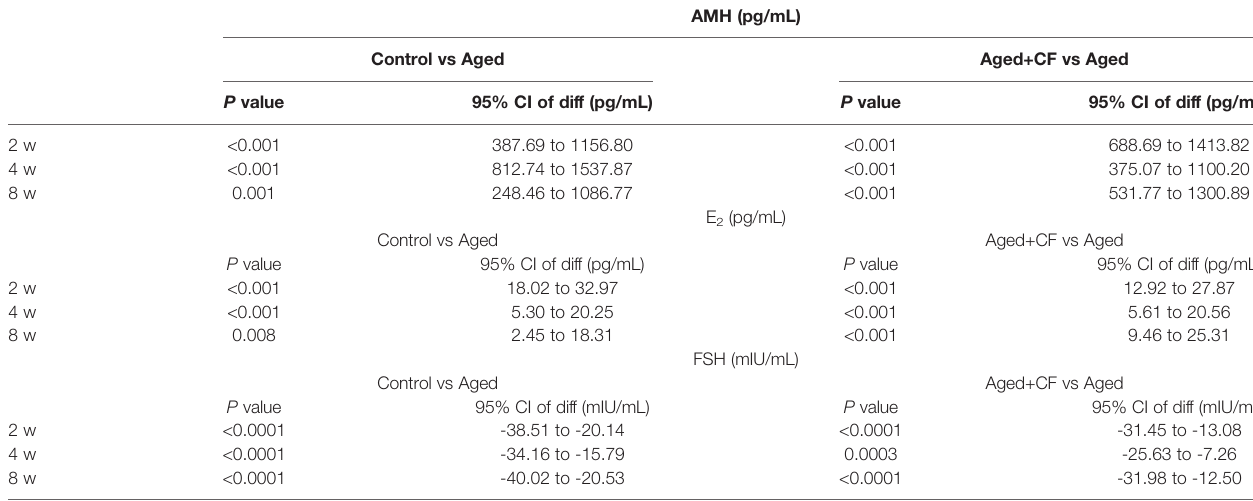
TABLE 1 | The P value and 95% CI of diff in AMH, E 2 and FSH